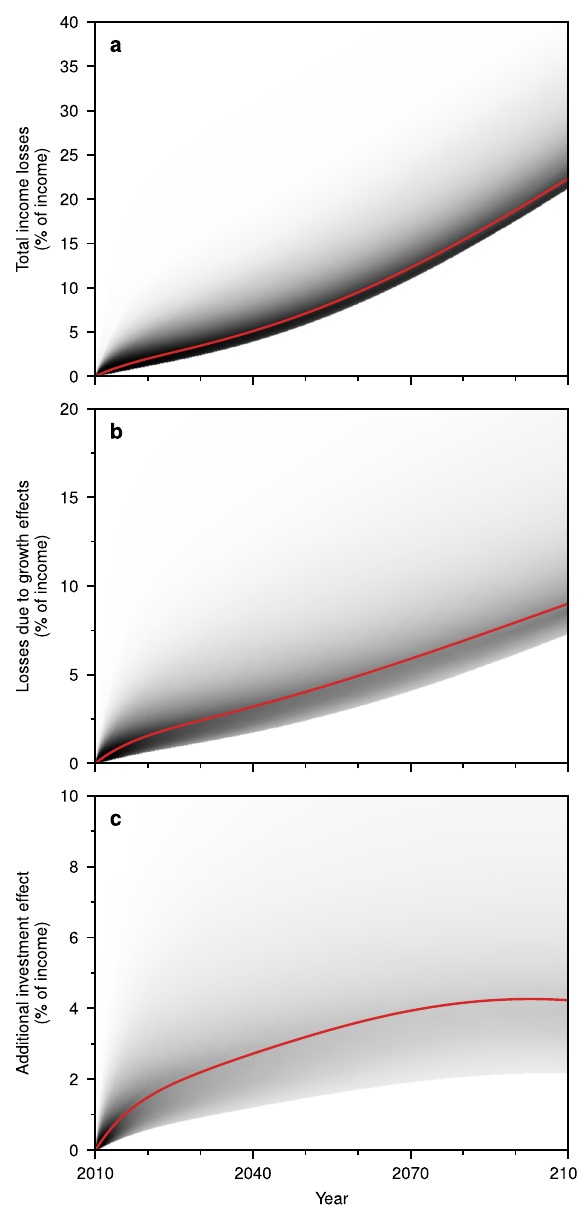
Fig. 5 The in fl uence of social preferences on the growth effects and income losses. Depicted are (relative to the income without climate change) the shares of ( a ) the total income losses; b the income losses caused through the growth effects; and ( c ) the income losses induced by the additional investment effect. Their magnitude depends on the social preferences. Solutions for alternative social preferences are illustrated by the grey area around the baseline solutions (red curves). The parameters are chosen uniformly within the unhatched area in Fig. 6. The shade of grey indicates the frequency with which the solution occurs. Source data are provided as a Source Data fi le.